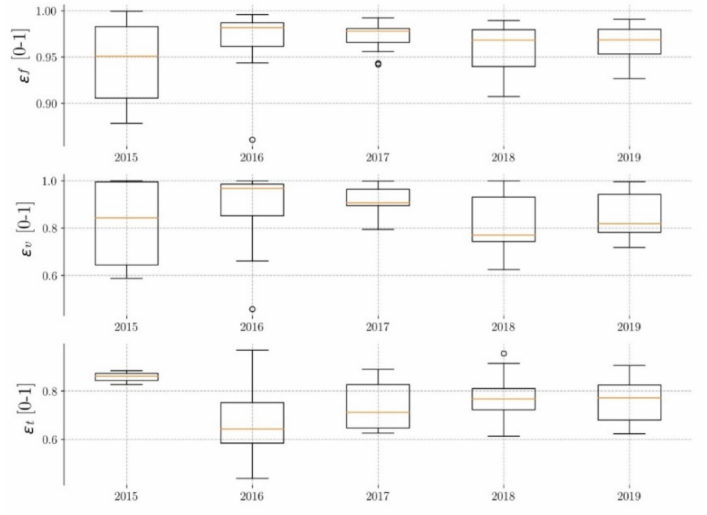
Figure 7. Evolution of pavement P2 e ffi